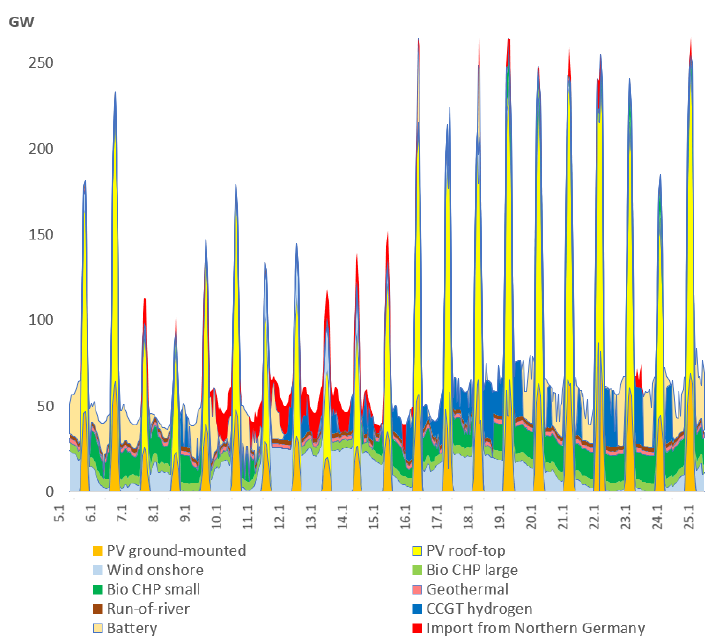
Figure 2. Load coverage in southern Germany in January 2017. Critical periods with particularly weak sunshine, as on 11–15 January, will be absorbed by bioenergy, hydrogen, and imports from northern